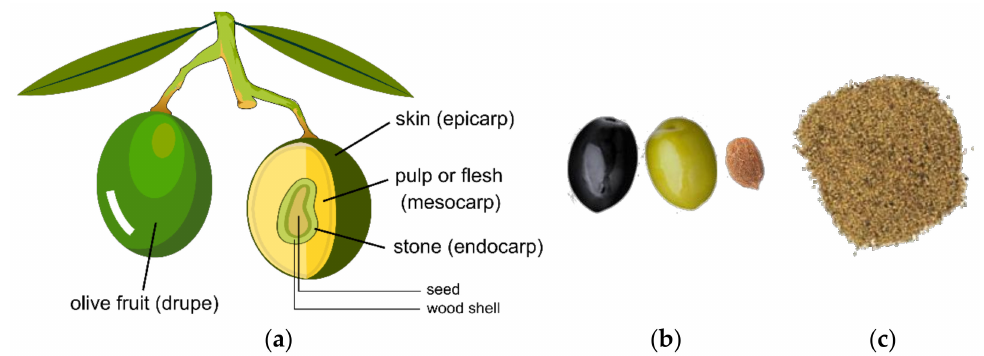
Figure 2. ( a ) Schematic of the cross-section of an olive fruit; ( b ) images of olive fruits and stone; ( c ) image of olive stone granules mechanically grounded, sifted, de-oiled, and crushed from Olea europaea L.